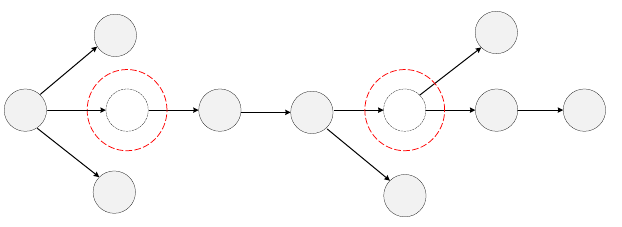
Figure 1. A complete COVID-19 transmission network. The dotted nodes marked with red circles are unsampled or asymptomatic spreaders.